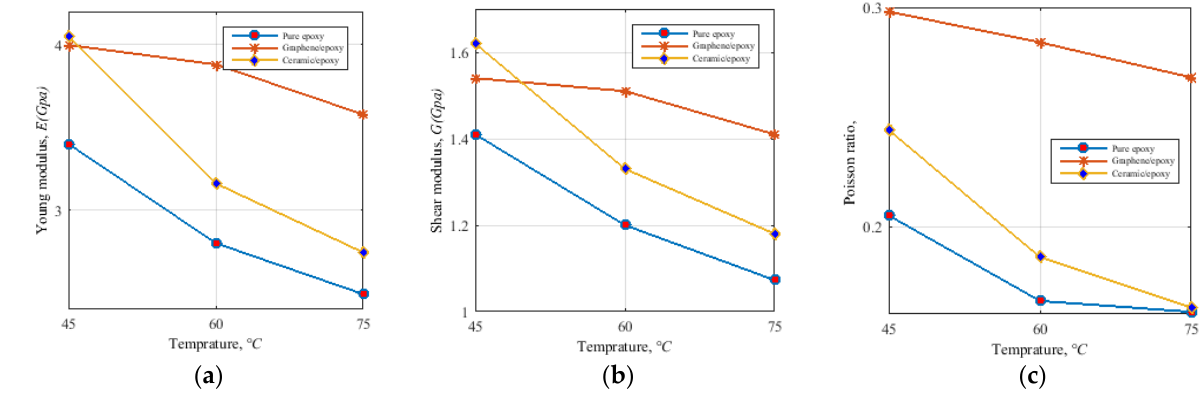
Figure 4. ( a ) Trends of Young’s modulus ( b ) Trends of Shear modulus ( c ) Trends of Poisson’s Ra- tio. Table 4. Graphene/Epoxy sample reading at temperatures.